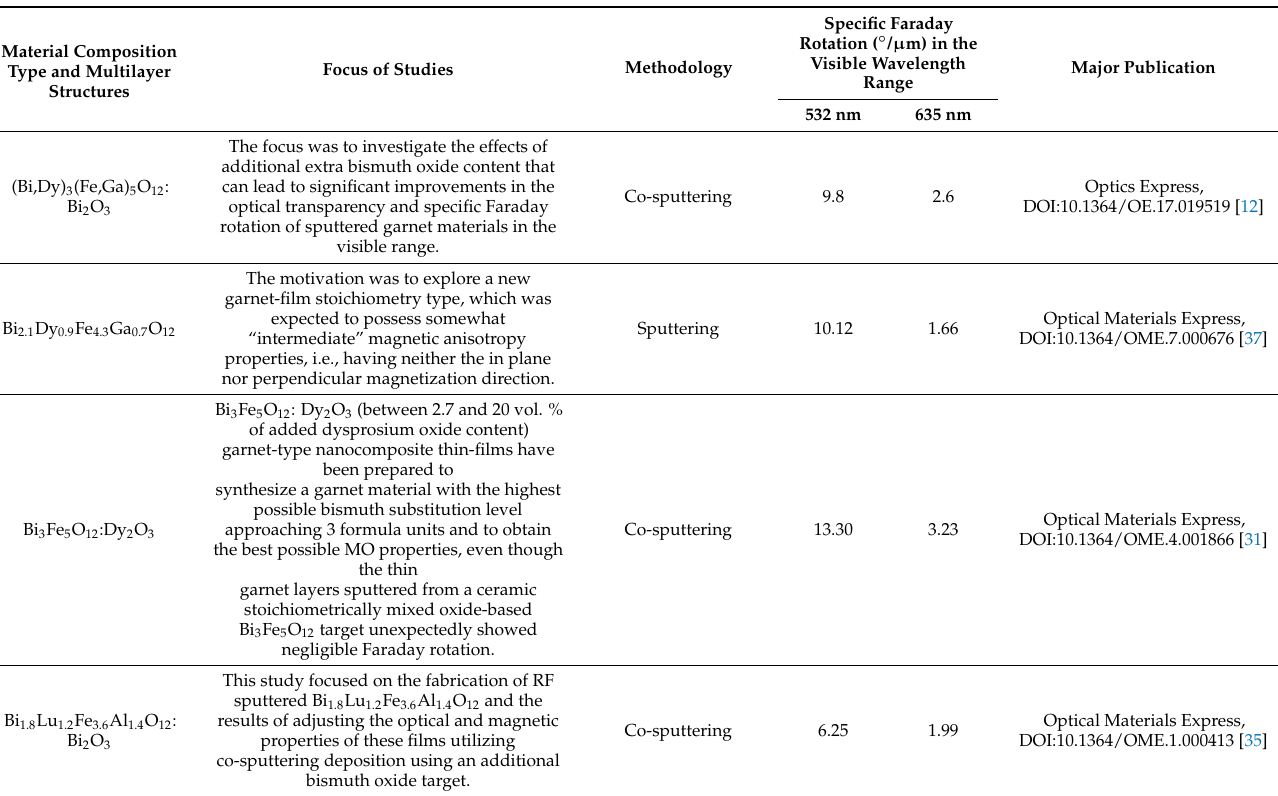
Table 1. Types of materials composition, study focus, methodologies used, and the best (highest) obtained specific Faraday rotations in the visible